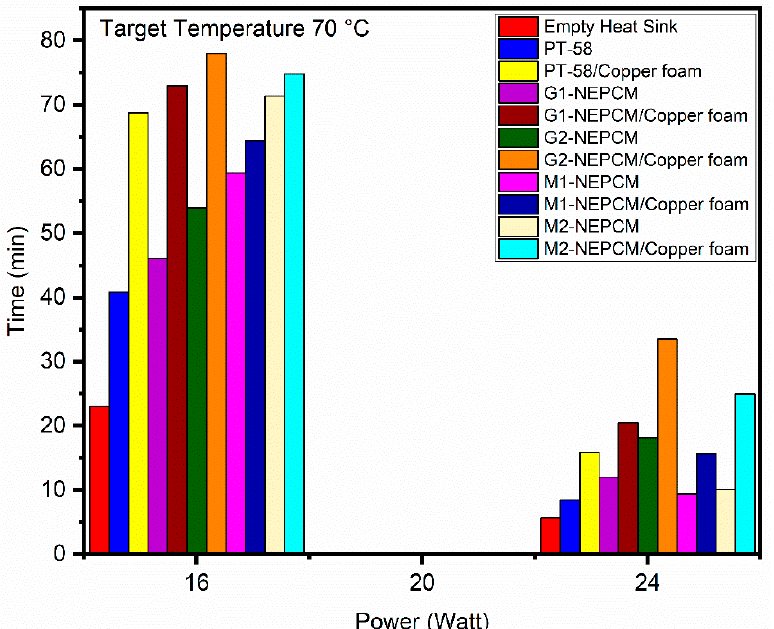
Figure 21. Time to attain target temperature of 70 ◦ C for heat sink filled with PCM, NEPCM and NEPCM/copper foam composites.